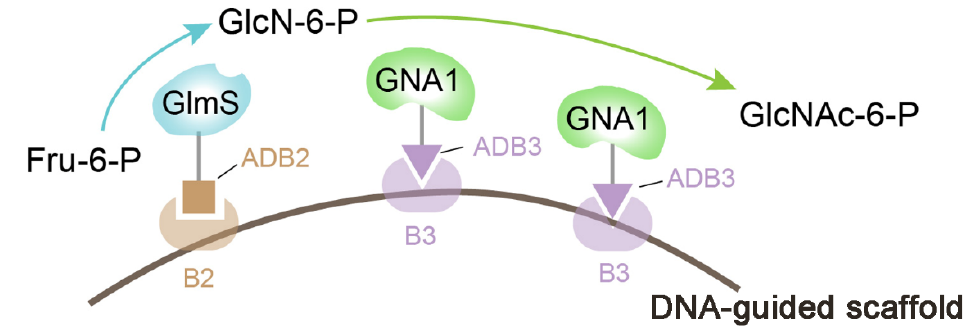
Figure 2. Schematic diagram of the spatial organization of GlmS and GNA1. The zinc finger protein ADB2 (corresponding to B2 binding sequence) was fused with GlmS, and ADB3 (corresponding to B3 binding sequence) was fused with GNA1. GlmS: glucosamine-6-phosphate synthase; GNA1: GlcNAc (N-acetylglucosamine)-6-phosphate N-acetyltransferase; Fru-6-P: fructose-6-phosphate; GlcN-6-P: glucosamine-6-phosphate; GlcNAc-6-P: N-acetylglucosamine-6-phosphate.